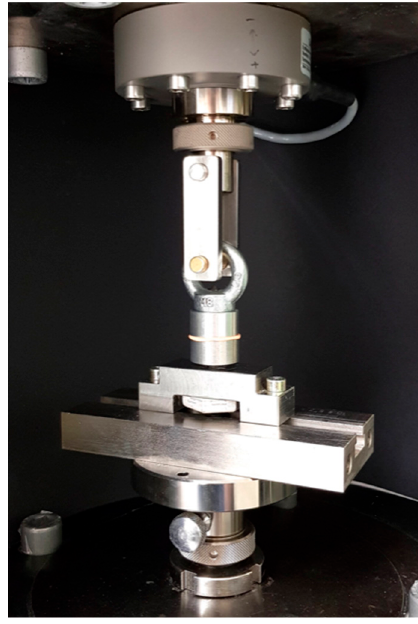
Figure 8. Testing specimens fixed into universal testing machine Zwick 1445 for pull out tests.